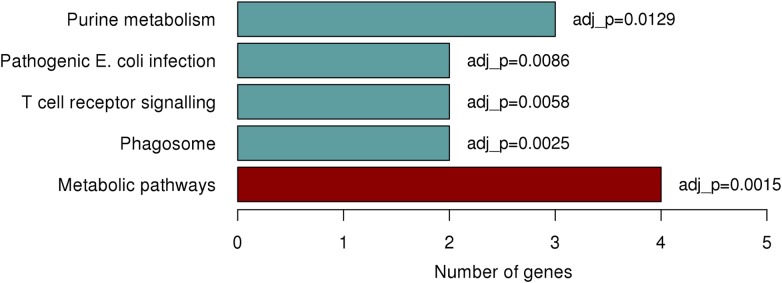
Significantly enriched pathways identified from KEGG enrichment analysis.